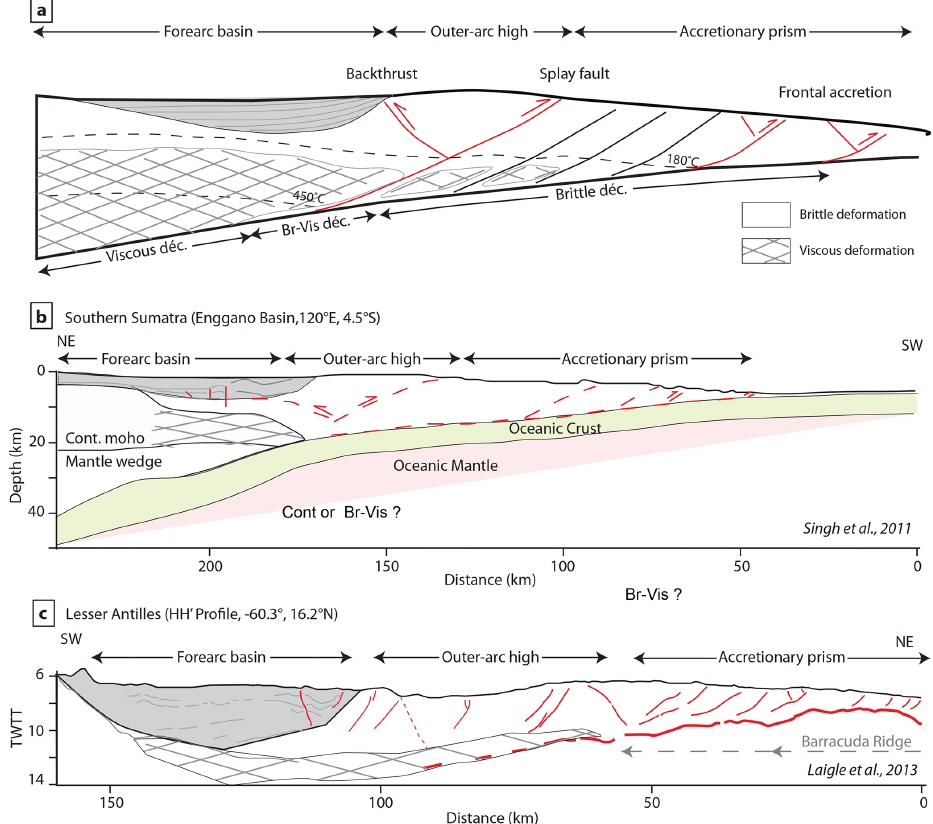
Figure 10. (a) Structure of accretionary wedge and forearc basin modified from Noda (2016) based on our modeling results for the geometry of isotherms and the distribution of brittle and viscous strain. Schematic cross sections of (b) South Sumatra based on Singh et al. (2011). (c) Lesser Antilles based on Laigle et al. (2013) with indication of the possible location of the brittle–ductile transition based on our model and the observed geometry of